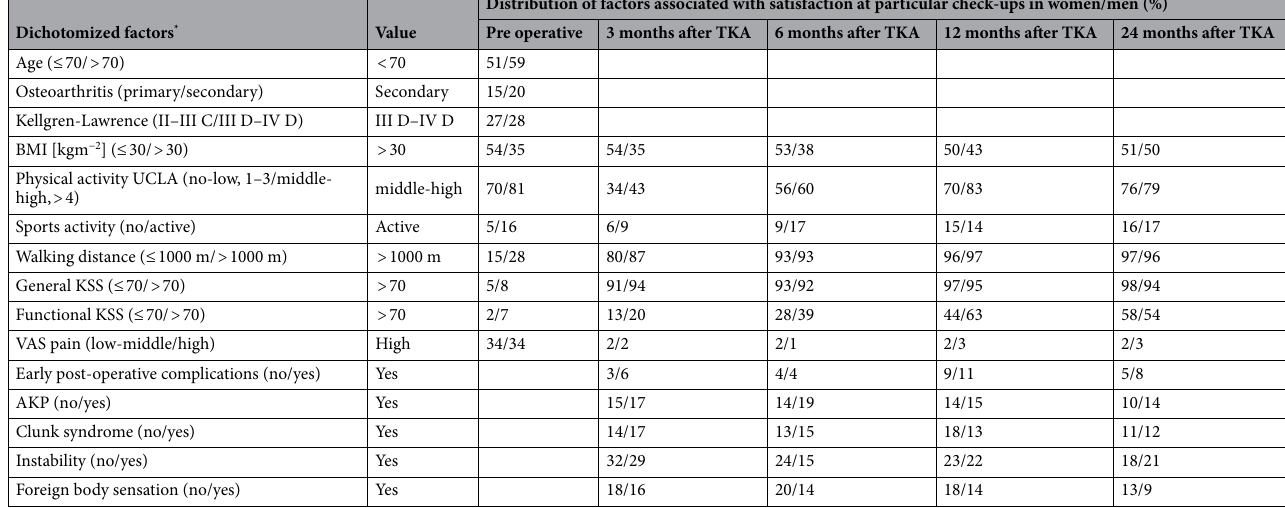
Table 1. Personal and clinical preoperative parameters in enrolled TKA patients subgrouped according to sex (1,121 women/650 men). All factors were dichotomized (according to the values shown in parentheses); the distribution of factors associated with satisfaction at particular check-ups is shown. n, number; AKP, anterior knee pain; BMI, body mass index; TKA, total knee arthroplasty; VAS, visual analogue scale; KSS, Knee Society score; UCLA, University of California. *Dichotomization was performed considering the distribution of parameter values in the studied cohort and their clinical relevance (see Gallo et al. 14